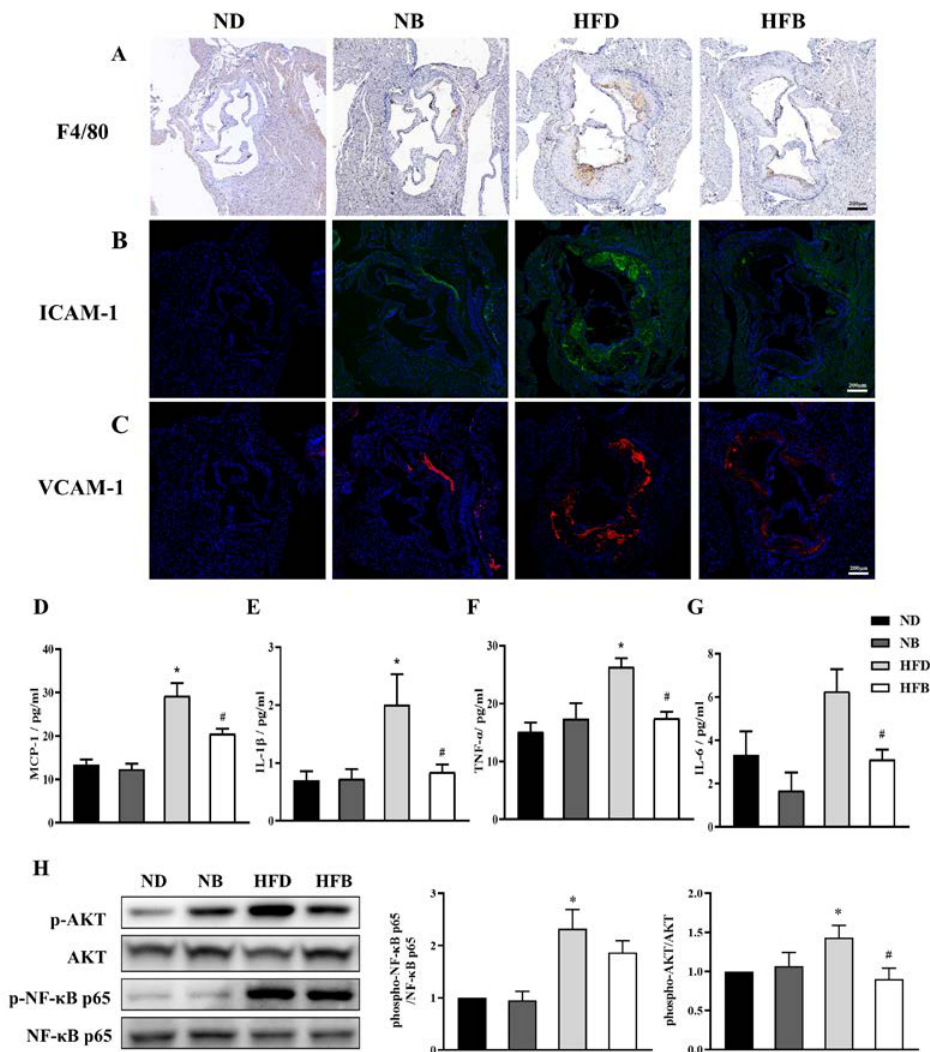
Figure 4. BCAA supplementation relieves inflammation induced by a high-fat diet in ApoE −/− mice. ( A ) Representative F4/80 immunohistochemical sections of aortic root (bar = 200 μm). ( B , C ) ICAM-1 ( B ) and VCAM-1 ( C ) expression at the aortic root was determined by immunofluorescence staining. ( D – G ) The expression of inflammatory cytokines, including MCP-1 ( D ), IL- 1β ( E ), TNF- α ( F ), and IL-6 ( G ), was measured using ELISA kits. ( H ) Representative western blot bands of AKT, p -AKT, NF- κB, and p -NF- κB in the aortic root (left). The relative quantitative data for AKT/ p -AKT (middle) and NF- κB/ p -NF- κB (right) are indicated. The data are expressed as the mean ± SEM ( n = 8 for